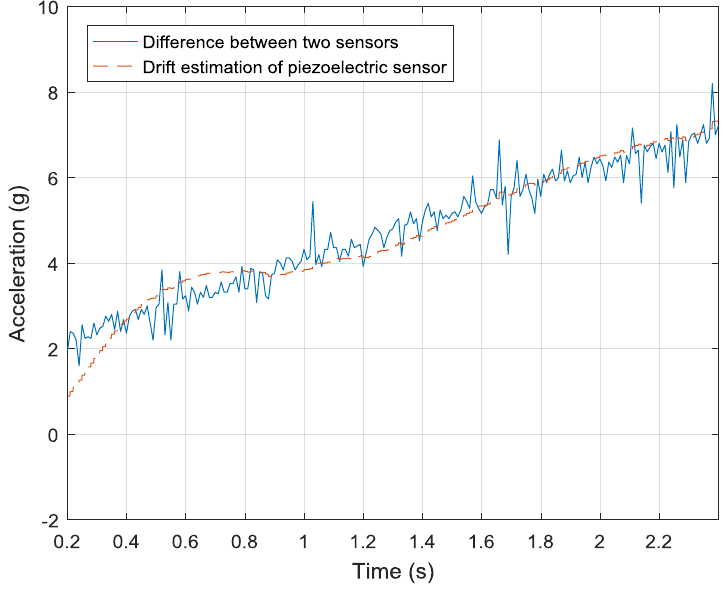
Figure 11. Drift estimation of piezoelectric sensor.